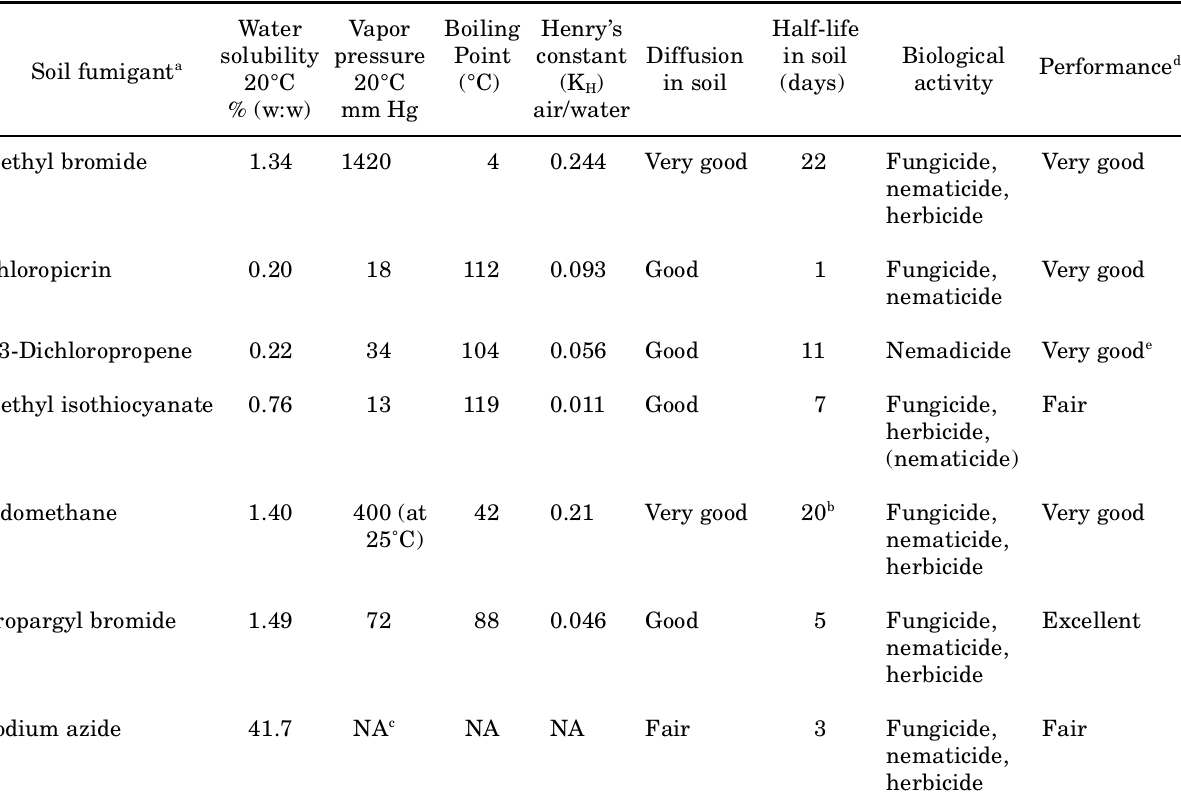
Table 3. Selected physical and chemical properties and biological activity of methyl bromide and chemical alterna- tives (adopted from Ajwa et al . 2002 and Gullino et al .,